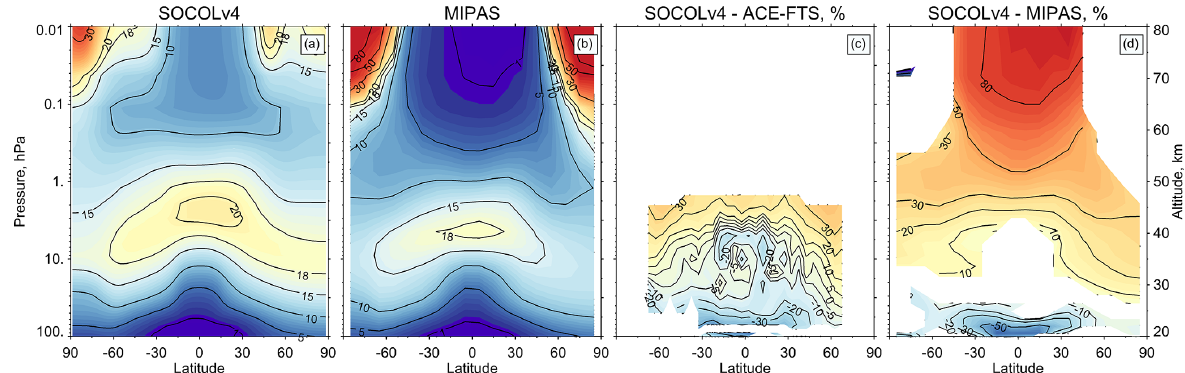
Figure 11. NO y zonal mean annual mean climatology (ppbv) calculated by (a) the SOCOLv4 model and (b) provided by MIPAS. (c, d) Rel- ative difference between the model and the ACE-FTS and MIPAS observations. White areas are either the missing data or regions where the difference between model and observations is not statistically significant at the 95% confidence level.